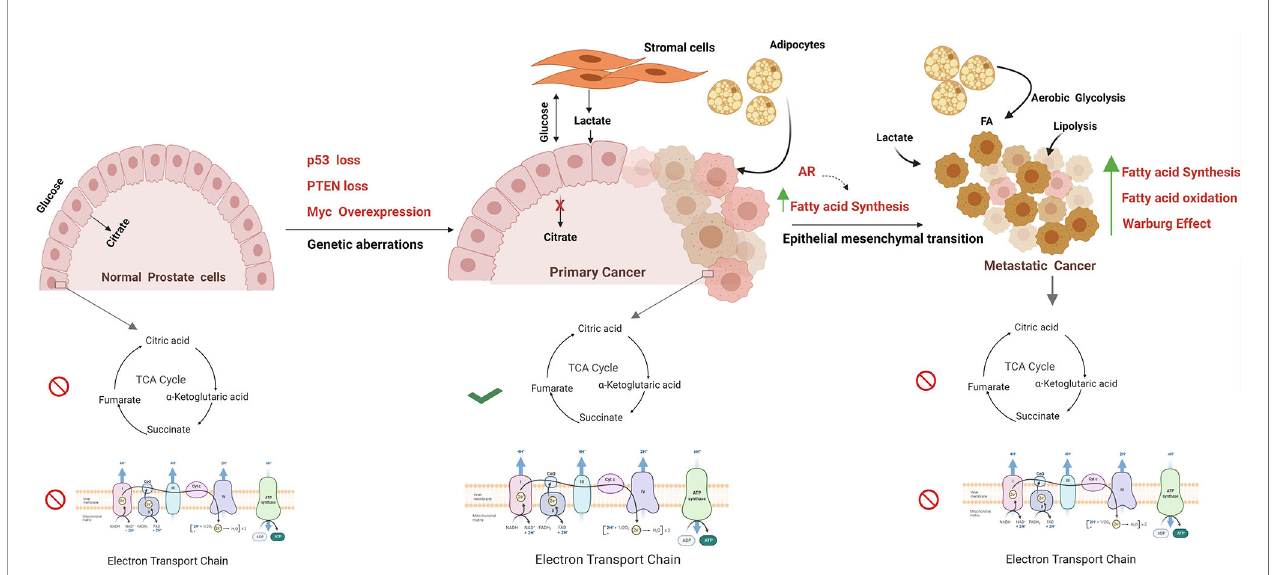
FIGURE 1 | Metabolism alterations in prostate cancer cell. The fi gure represents the metabolic alterations during prostate cancer metastasis. The normal prostate epithelial cells are characterised with increased release of citrate in seminal fl uid, abbreviated Krebs cycle, and reduced oxidative phosphorylation rate. Normal prostate cells undergo transformation due to genetic aberrations; for example, MYC overexpression, PTEN loss, p53 loss, mutations, and other tumor suppressors result in activation of TCA cycle and oxidize citrate and generate Acetyl CoA for lipid biosynthesis. Besides, these fatty acids are fuelled into TCA cycle through lipolysis of adipocytes. Increased Warburg effect is a common feature in metastatic PCa with high lactate secretion, provided by cancer-associated fi broblasts. Progression towards mCRPC is marked by epithelial to mesenchymal transition. In metastatic stage, energy demand is met by both fatty acid oxidation and fatty acid synthesis. The fi gure has been drawn using Biorender